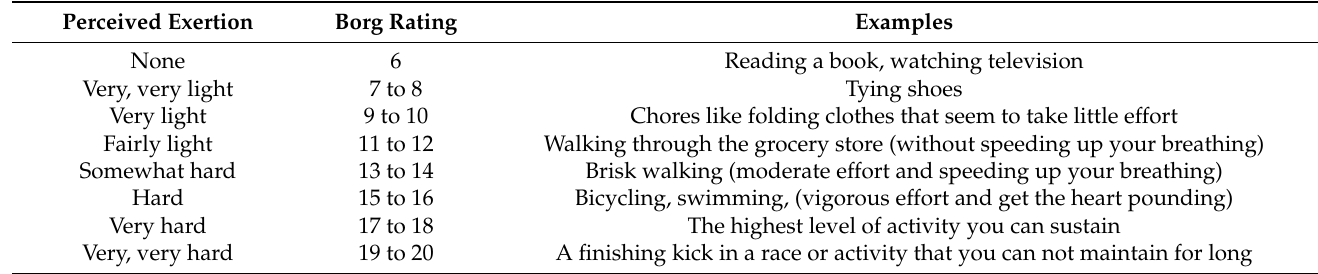
Table 1. Borg G.A. psychophysical bases of perceived exertion